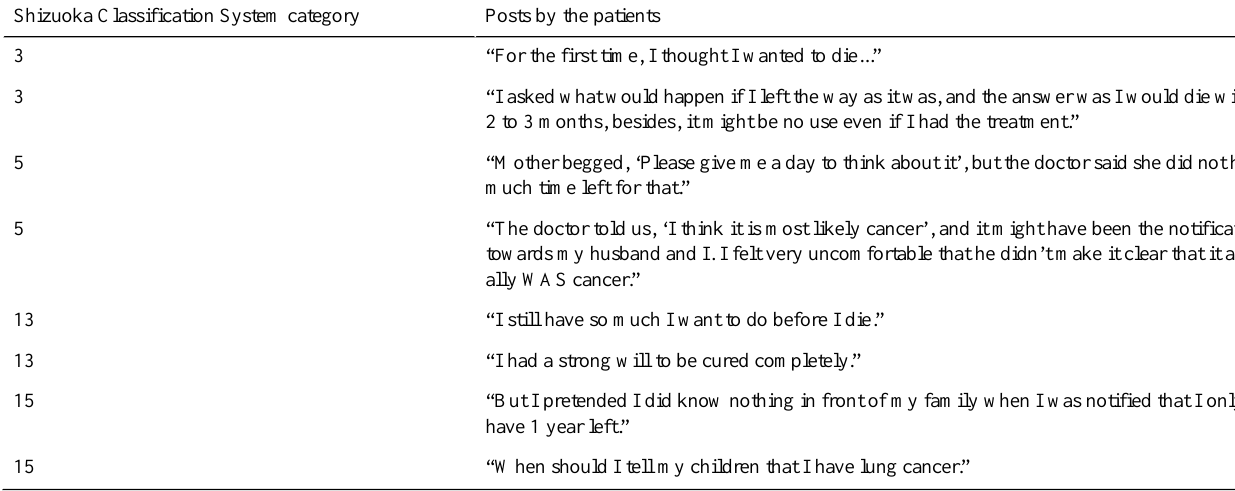
Table 3. Some examples of the actual social networking site posts by patients and their family members (n=100) with Shizuoka Classification System categories.